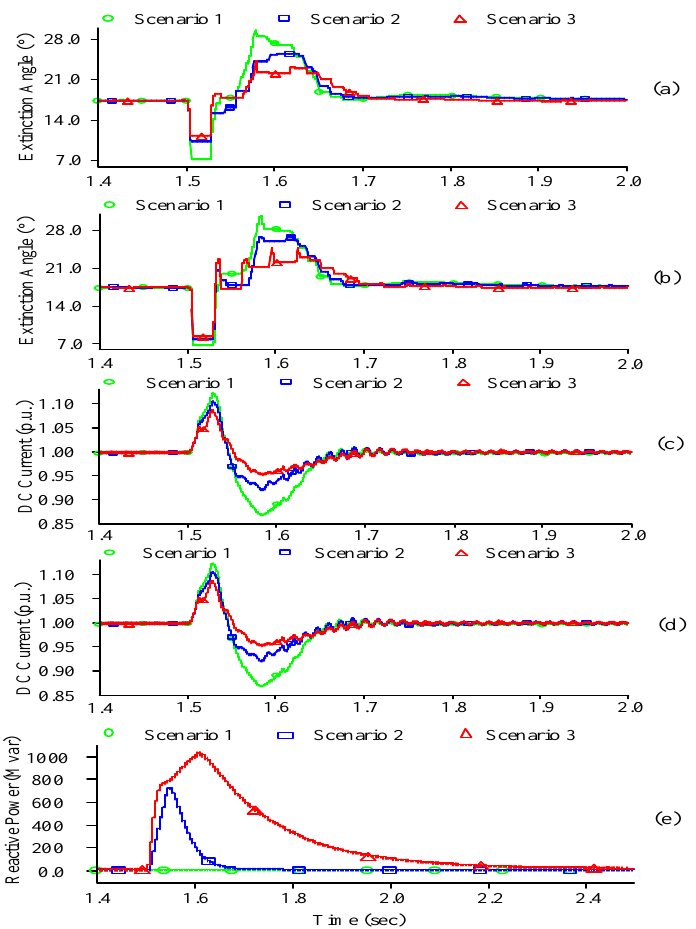
Figure 8. Simulation results for a three phase fault. ( a ) Extinction angle of the HEC; ( b ) Extinction angle of the LEC; ( c ) DC current of the HEC; ( d ) DC current of the LEC; ( e ) Reactive power of the STATCOM.